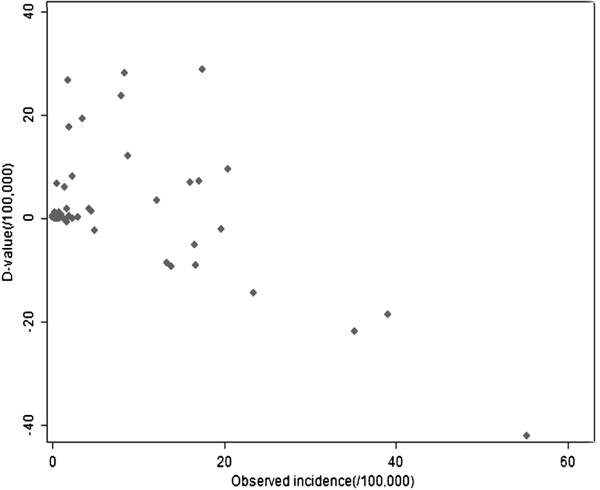
Scatterplot of difference between expected values predicted by model 1 and observed values of malaria incidence in the study period of 2006–2010.